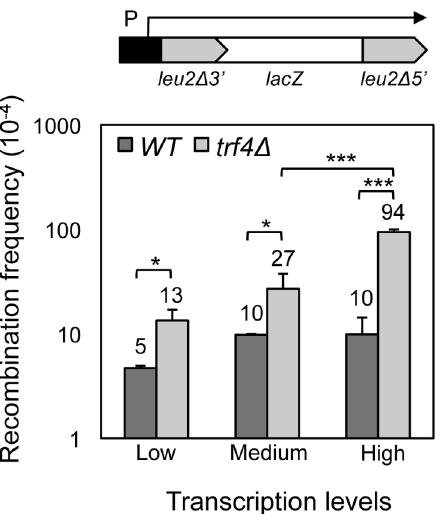
Figure 2. Effect of the level of transcription on the trf4 D hyperrecombination phenotype. Isogenic strains W303-1A (WT) and TRF4D-C5 ( trf4 D ) were transformed with plasmids pSCH204 (L- lacZ recombination system) or pRS314GL-lacZ (GL- lacZ) in which transcrip- tion is under the control of LEU2 and GAL1-10 promoters, respectively. Gray boxes represent LEU2 repeats that flank the lacZ sequence. Arrow indicates the transcript produced. P. Promoter. Recombination fre- quencies are plotted as a function of the transcription levels. Low transcription refers to the GL- lacZ systems in strains cultured in 2% glucose; medium refers to L- lacZ in 2% glucose, and high to GL- lacZ in 2% galactose. The average median value and SD of 3-4 fluctuation tests are shown. Asterisks indicate statistically significant differences between the strains indicated, according to Student’s t-tests (*, R , 0.05; ***, R , 0.0005).